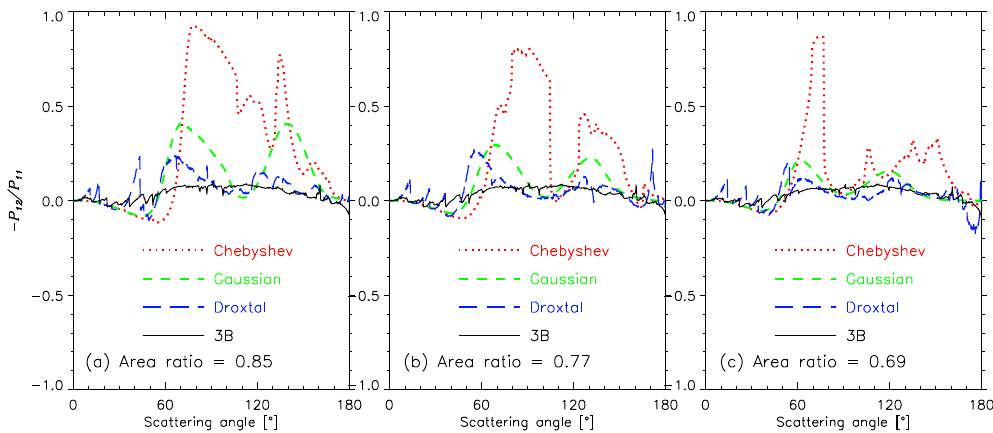
Fig. 13. Degree of linear polarization ( − P 12 /P 11 ) and for Chebyshev particles, Gaussian random spheres, droxtals, and 3Bs with varying area ratio of 0.85 (a) , 0.77 (b) , and 0.69 (c) . Here, aspect ratio of 1.43 is used for 3Bs.